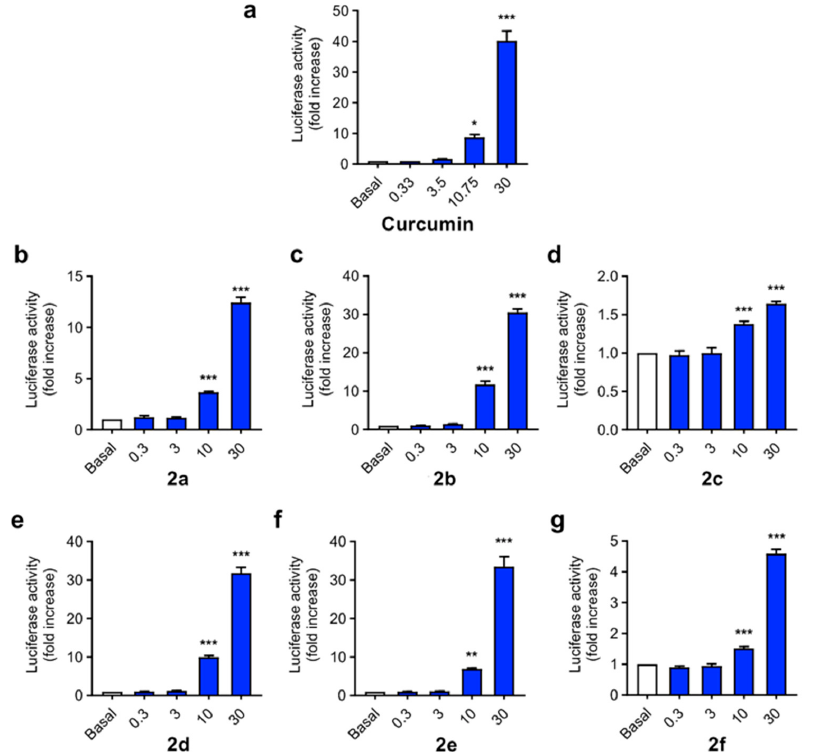
Figure 3. Phase II antioxidant response activation capacity of compounds 2a – f compared to